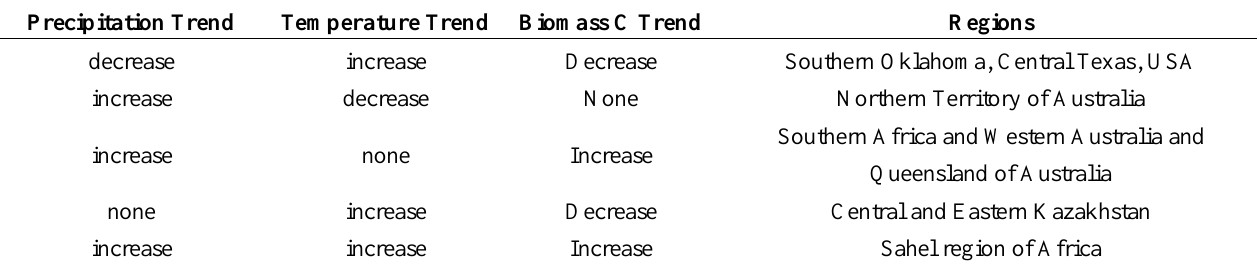
Table 3. Regional examples of association of the changes in precipitation, temperature, and aboveground biomass